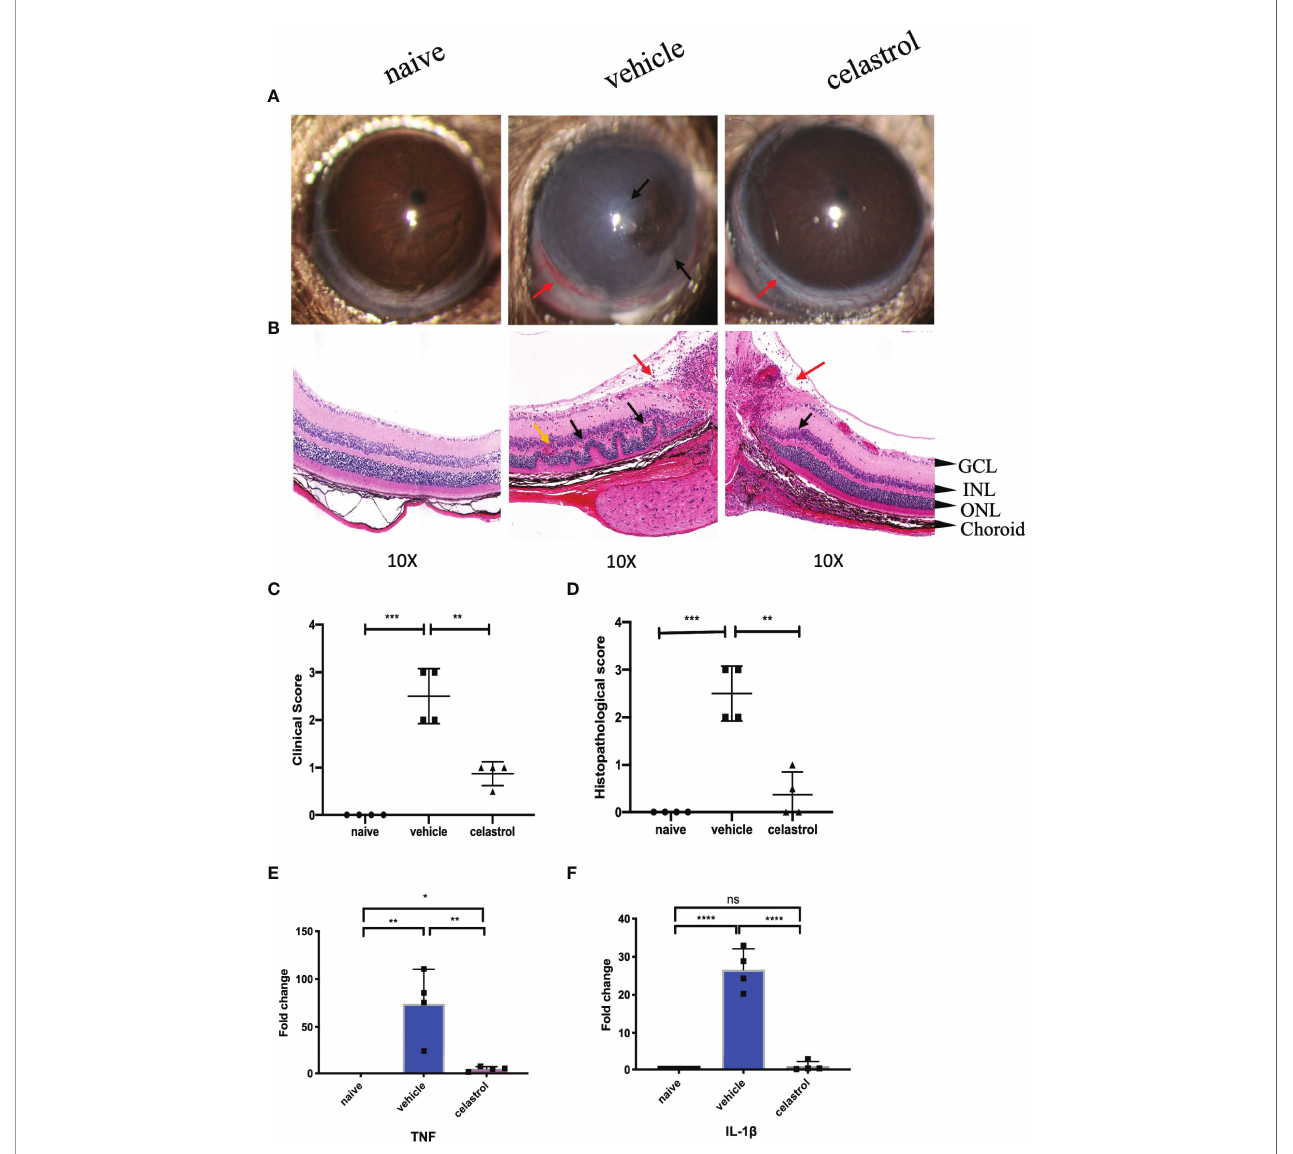
FIGURE 8 | Celastrol alleviated EAU and inhibited the expression of TNF and IL-1 b in the retinas of EAU. (A) Representative slit-lamp photographs of the naive group, the vehicle intervention group, and the celastrol intervention group on day 14 (n = 4/group). Red arrow, conjunctival hyperemia. Black arrow, in fl ammatory exudation. (B) Representative staining images of HE sections in the naive group, the vehicle intervention group, and the celastrol intervention group on day 14 (n = 4/ group). Red arrow, vitreous in fl ammatory cell in fi ltration. Black arrow, retinal fold. Yellow arrow, neovascularization, and hemorrhage (GCL, ganglion cell layer; INL, inner nuclear layer; ONL, outer nuclear layer). (C) The clinical score of the naive group, the vehicle intervention group, and the celastrol intervention group on day 14 (n = 4/group). (D) The histopathological score of the naive group, the vehicle intervention group, and the celastrol intervention group (n=4/group). (E) qRT-PCR analysis of TNF in retinas of the naive group, the vehicle intervention group, and the celastrol intervention group on day 14 (n = 4/group). (F) qRT-PCR analysis of IL- 1 b in retinas of the naive group, the vehicle intervention group, and the celastrol intervention group on day 14 (n = 4/group). * P < 0.05; ** P < 0.01; *** P < 0.001; ****P < 0.0001 (two-tailed student ’ s t -test). Graphs show mean ±